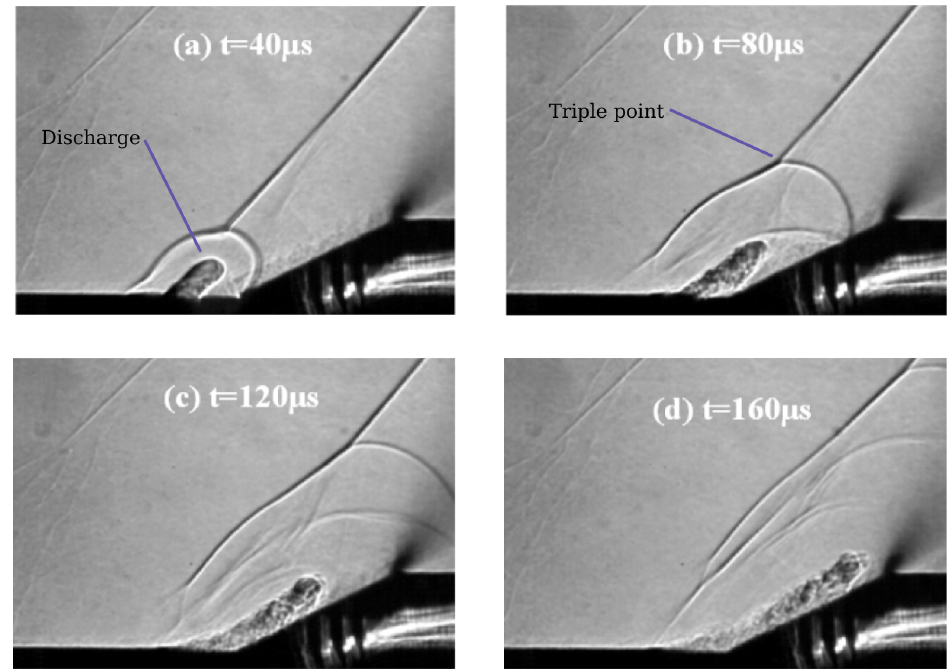
Figure 57. Interaction of energy deposition with shock. Reprint from [109] with permission from Elsevier.